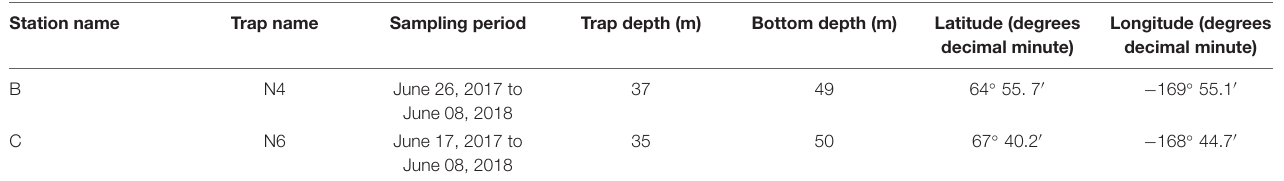
TABLE 2 | Location and duration of moored sediment